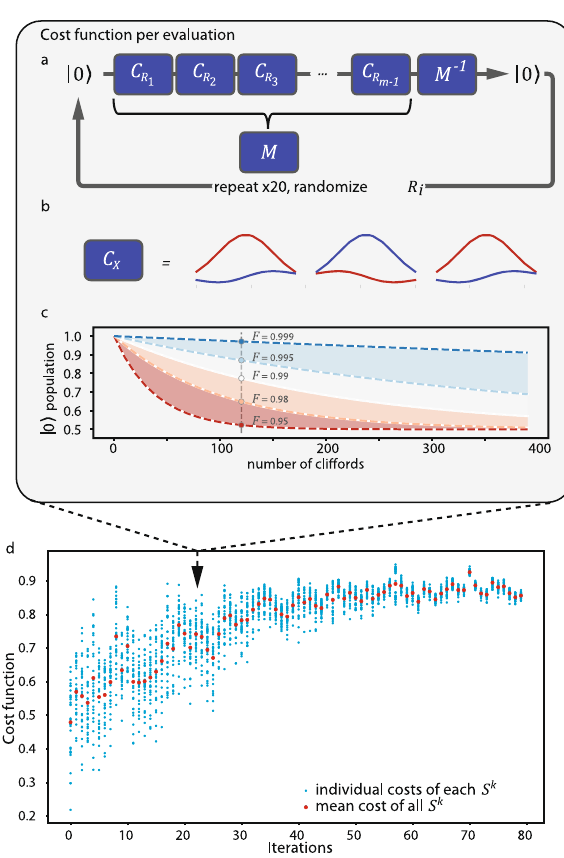
Fig. 2 Key components of the pulse optimization. a Single-qubit Clifford gate sequence of length m . b Schematic visualization of the composition of a Clifford gate from ± X /2, ± Y /2 pulses based on a speci fi c pulse shape. The Ω x and Ω y components are displayed in red and blue, respectively. c Sketch of ideal RB curves 1 þ F m ð Þ = 2 with the cost function for m = 120 Clifford gates indicated as points for several fi delities F . d Experimental data of a full optimization run for a 23 dimensional parameter space. Each blue point represents the cost function of each of the λ = 30 candidate pulse shapes based on a unique parameter set S k evaluated using 20 Clifford sequences. The red points represent the average cost function at each iteration of the